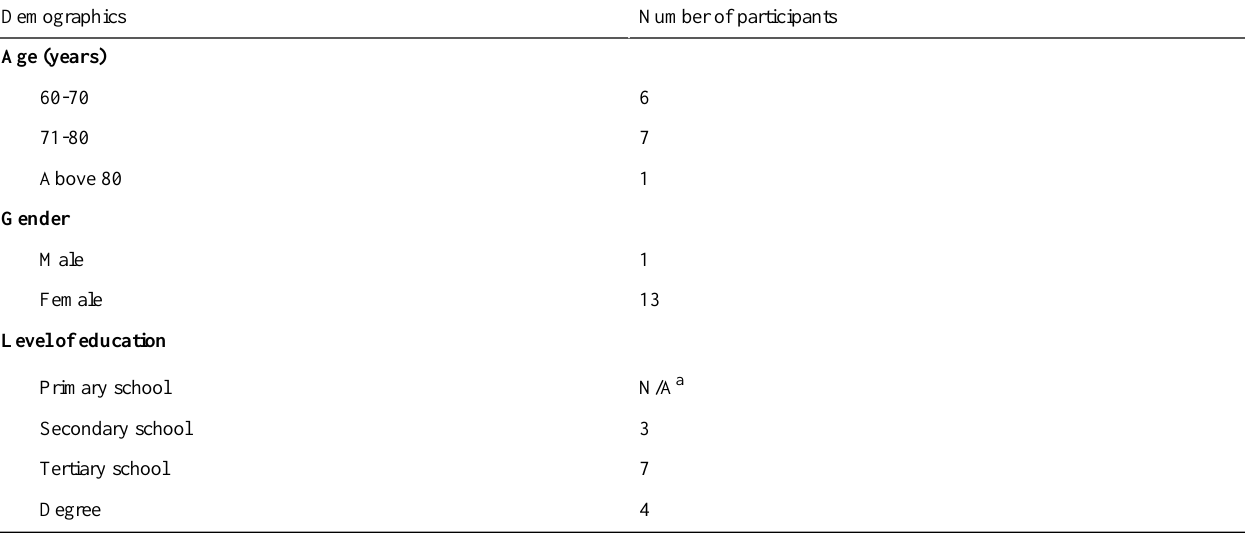
Table 1. Demographics of study participants.